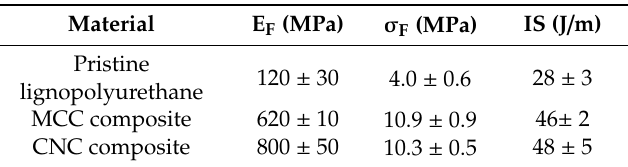
Table 1. Flexural modulus (at 5% deformation) (E F ), flexural strength ( σ F ), and Izod (unnotched) impact strength (IS) for the pristine lignopolyurethane, lignopolyurethane reinforced with MCC, and lignopolyurethane reinforced with